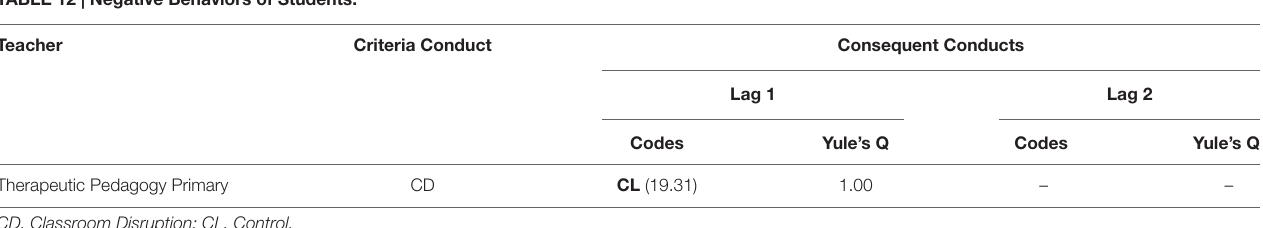
TABLE 12 | Negative Behaviors of Students.